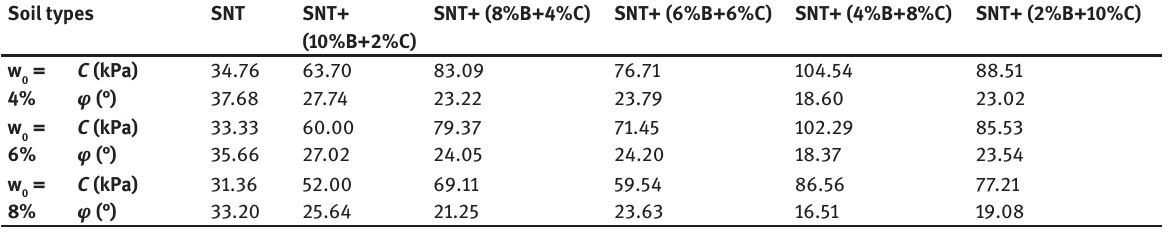
Table 7: Geotechnical characteristics of the different mixtures. Soil types